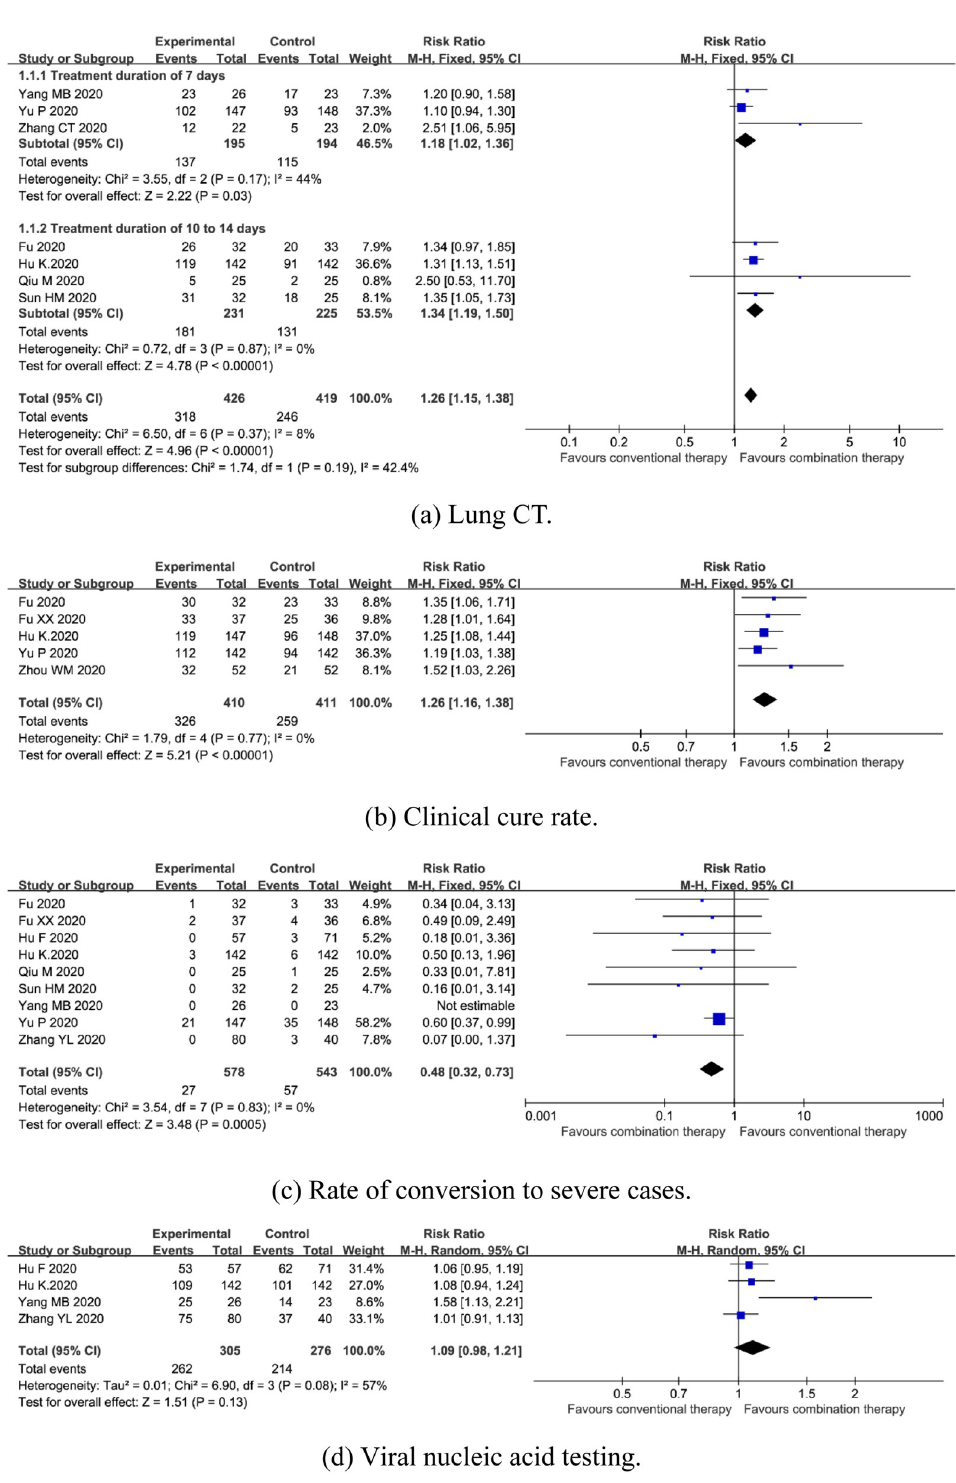
Fig 3. Forest plot of the effects of combination therapy for outcomes of (a) lung CT, (b) clinical cure rate, (c) rate of conversion to severe cases, (d) viral nucleic acid testing.